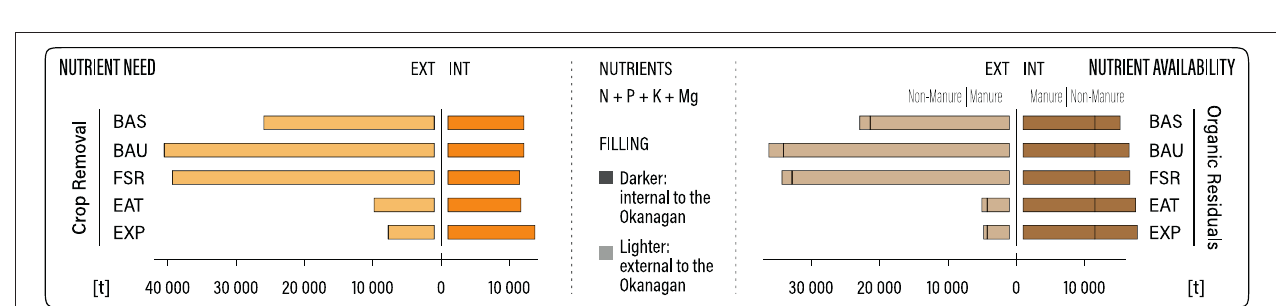
key model outputs are separate nutrient flows between subsystem components for the nine pathways shown in Figure 4